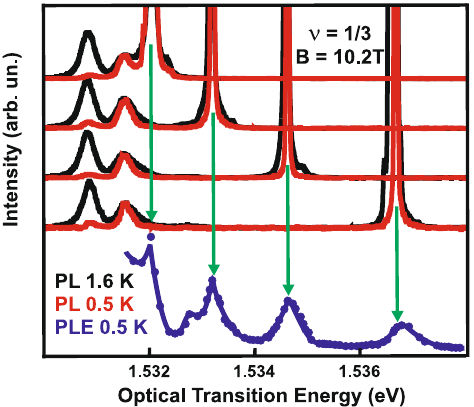
Fig. 3 Photoluminescence spectra of the Laughlin liquid ν = 1/3 measured for different excitation energies. Spectra given for the temperatures of 0.5 K (red lines) and 1.6 K (black lines). The energies for exciting the electron system are obtained from the photoluminescence excitation (PLE) spectra (blue dots and the solid line below). Regardless of the excitation resonance, the spectra exhibit no signi fi cant variations, indicating the universal nature of the change in the amplitude of photoluminescence (PL) signal observed at the forming of the Laughlin state ν = 1/3. Green arrows indicate the laser energy exciting the PL